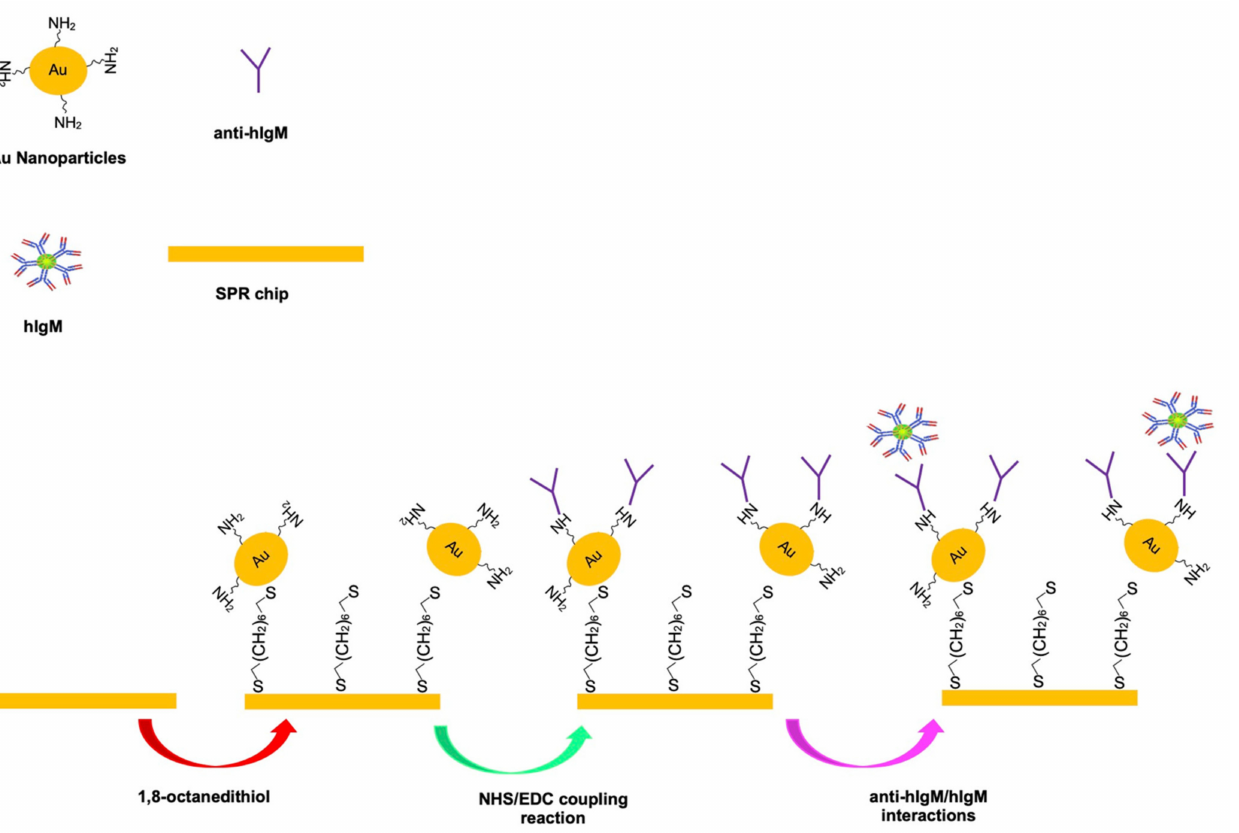
Figure 1. The schematic preparation of I-SPR